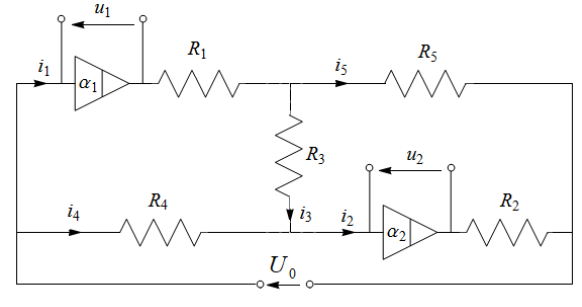
Figure 2. Diagram of the fractional order electrical